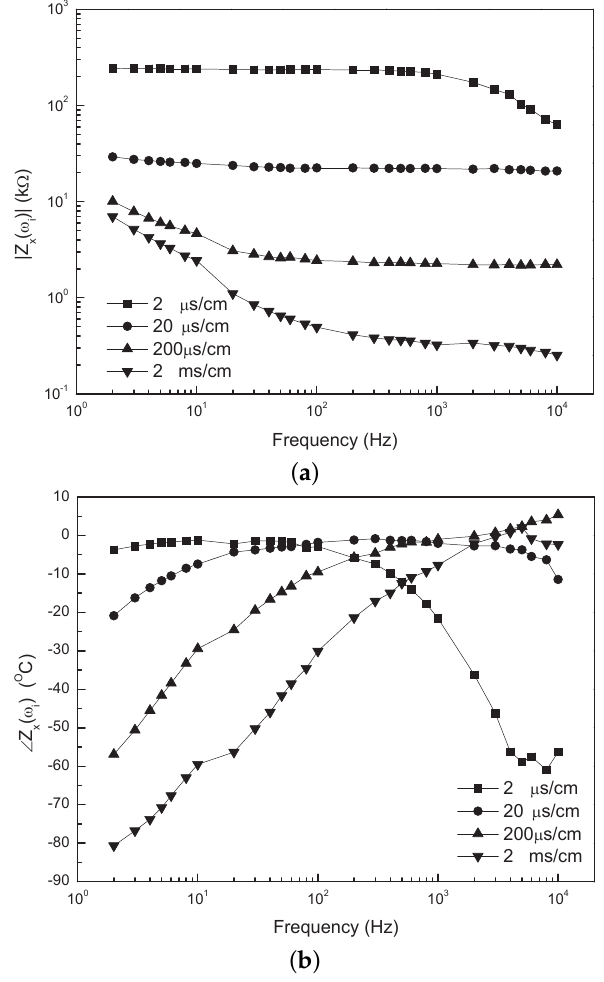
Figure 7. Bode plot of the measured impedance spectrum of the transducer for different solution conductivities. ( a ) Absolute value of impedance vs . frequency; ( b ) Phase of impedance vs .